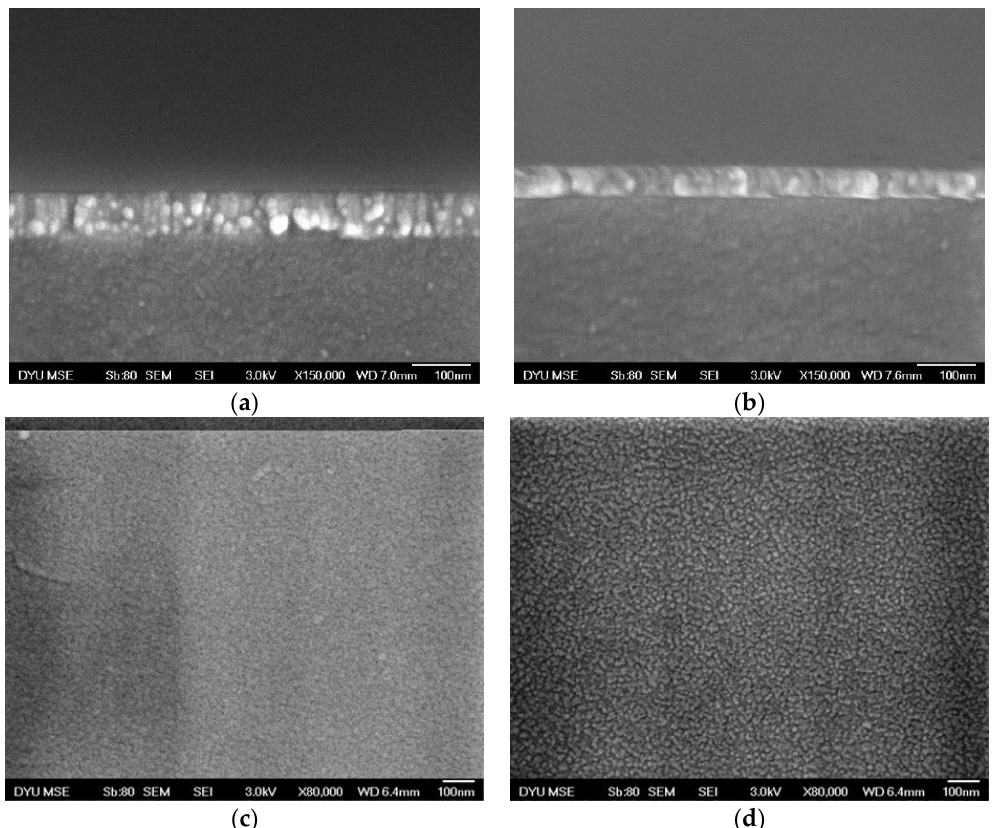
Figure 2. Full width at half maximum (FWHM, B) is a function of the annealed film at 300 °C.